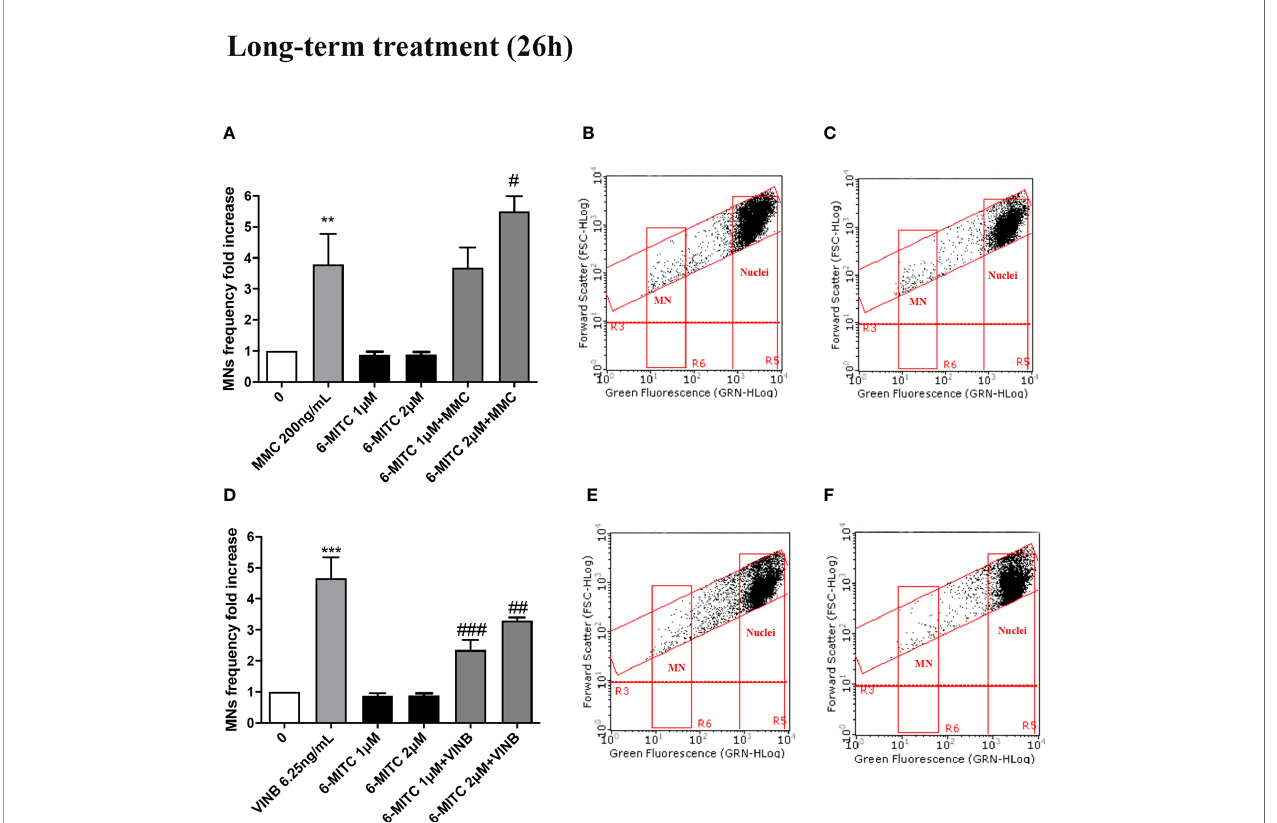
FIGURE 13 | Effect of 6-MITC on antimutagenesis after long term treatment. MNs frequency fold increase on TK6 cells treated for 26h with 6-MITC in presence or absence of MMC 200ng/mL (A) or VINB 6.25ng/mL (D) . Dot plot obtained by FCM of MMC 200ng/mL (B) , MMC 200ng/mL + 6-MITC 2µM (C) , VINB 6.25ng/mL (E) and VINB 6.25ng/mL + 6-MITC 2µM (F) . Each bar represents the mean ± SEM of fi ve independent experiments. Data were analysed using repeated ANOVA followed by Dunnet or Bonfferoni post-test. **p < 0.01 vs 0; ***P < 0.001 vs 0. # p < 0.05 vs MMC; ## p < 0.01 vs VINB; ### p < 0.001 vs